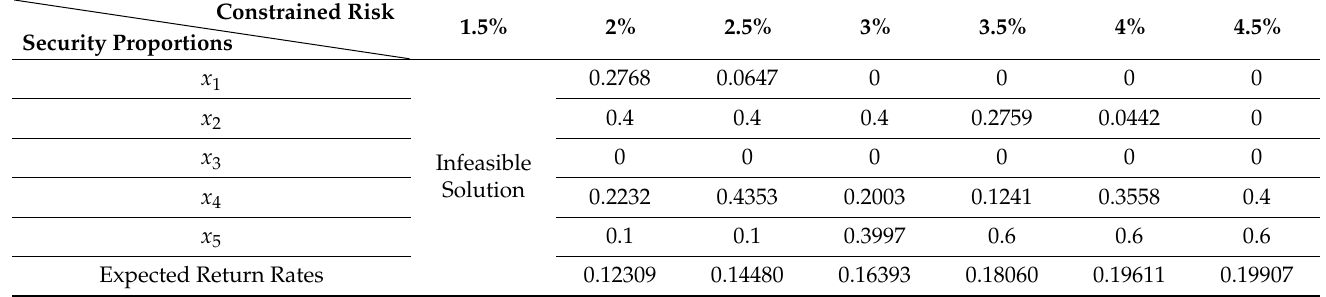
Table 14. The dimension with t = 2 and s = 3 with a guaranteed return rate (cid:101) p 2 in the proposed